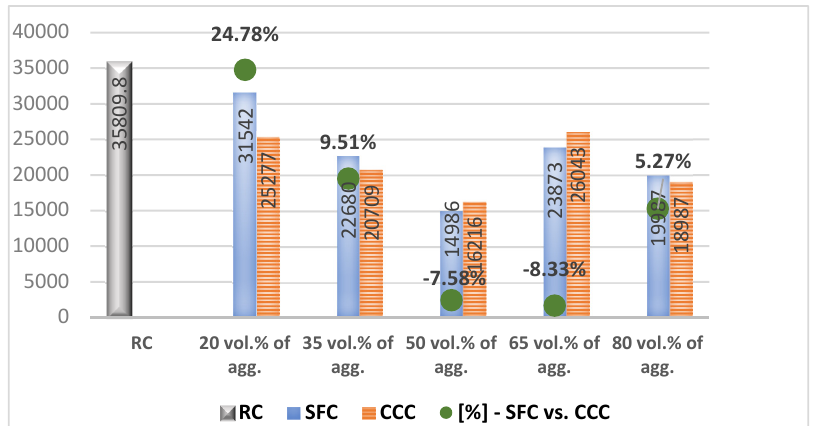
Figure 10. Modulus of elasticity of concrete with vegetal aggregates.